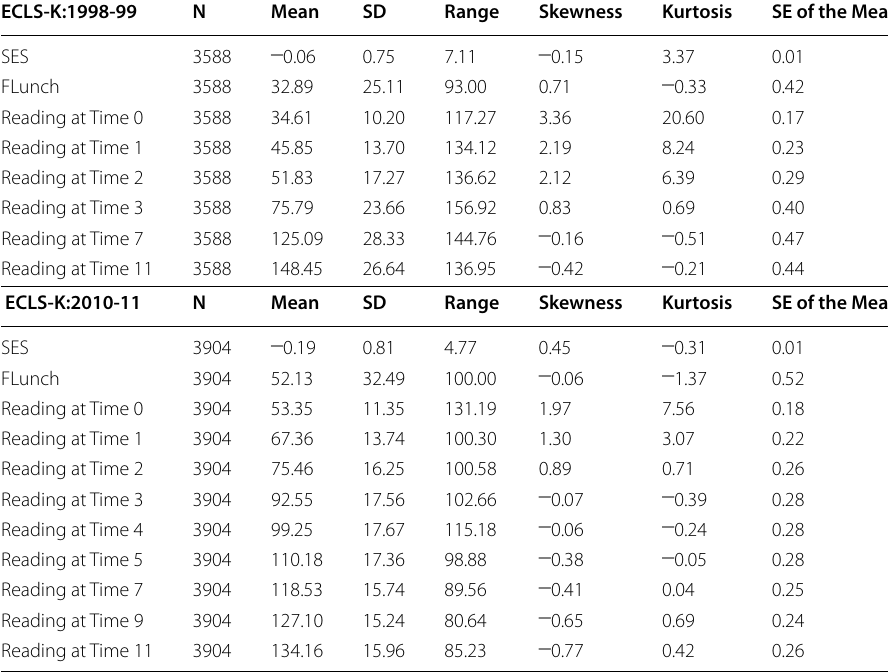
Table 1 Summary statistics for ECLS-K:1998-99 and